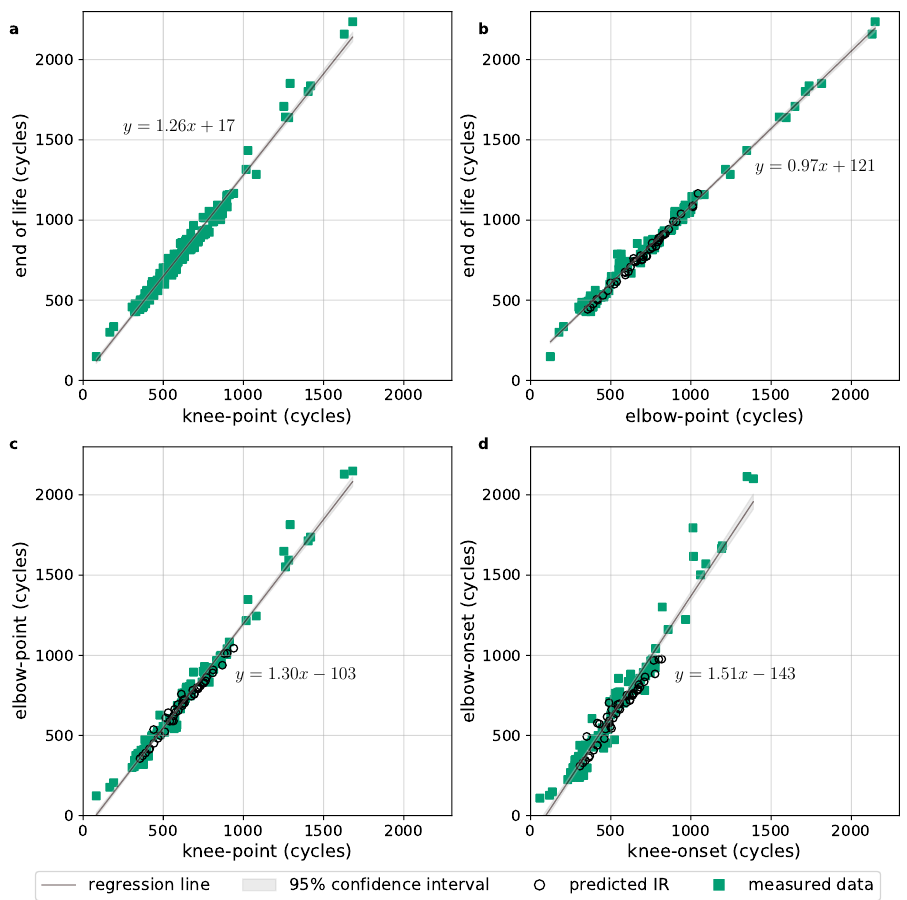
Figure 6. ( a ), Linear regression model linking the knee-point to end of life. ( b ), elbow-point to end of life. ( c ), knee-point to elbow-point. ( d ), knee-onset to elbow-onset. Every linear model is presented with a 95% confidence band on the plotted regression line; all linear relations here are calculated from the A123 dataset enriched with the predicted IR data for batch 8. Elbow points derived from the predicted IR data are highlighted as open black circles; the reader will appreciate that their inclusion did not significantly influence the linear regression results